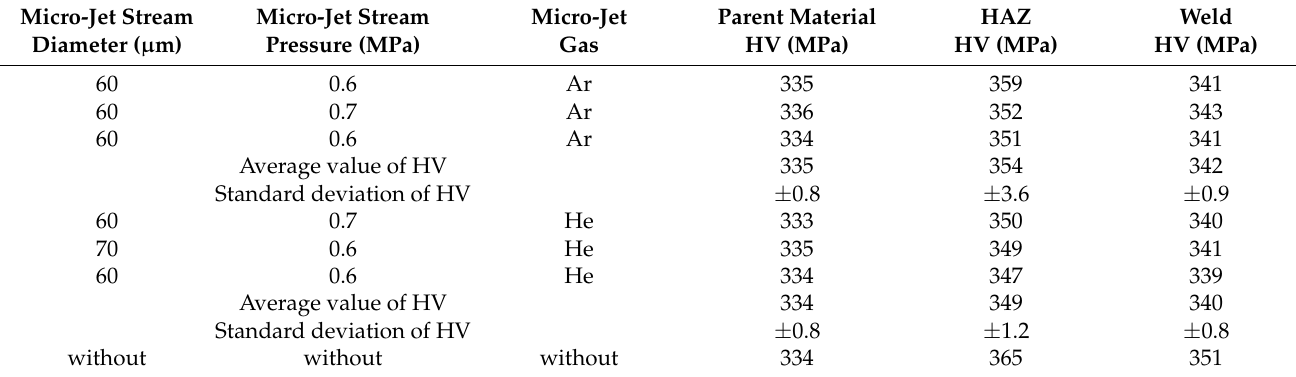
Table 3. Hardness values in a mixed joint at selected parameters of welding process, HV—Vickers Hardness. Micro-Jet Stream Diameter ( µ